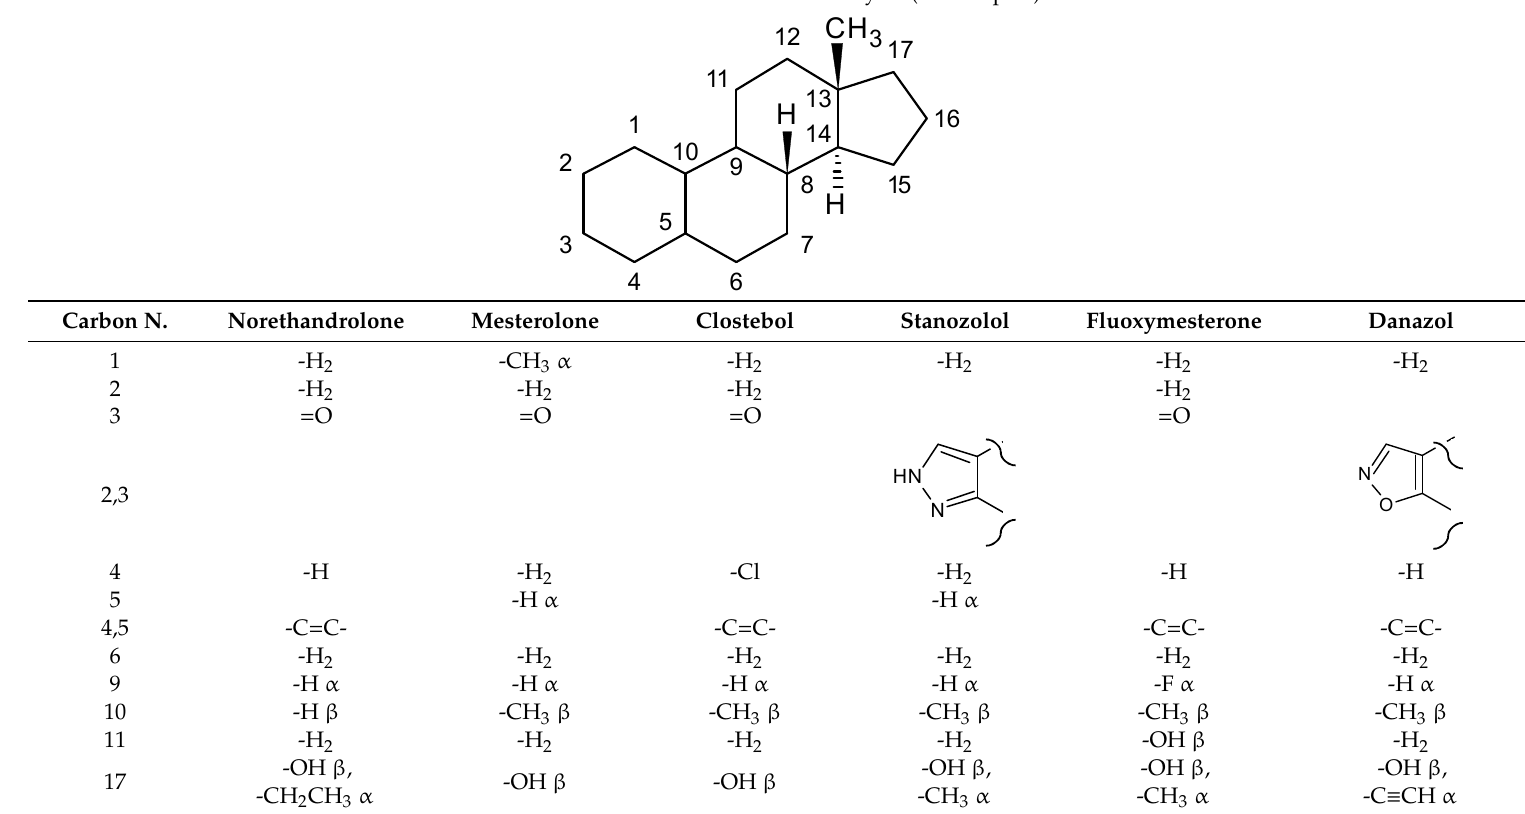
Table 2. Chemical structures of the analytes (second part).